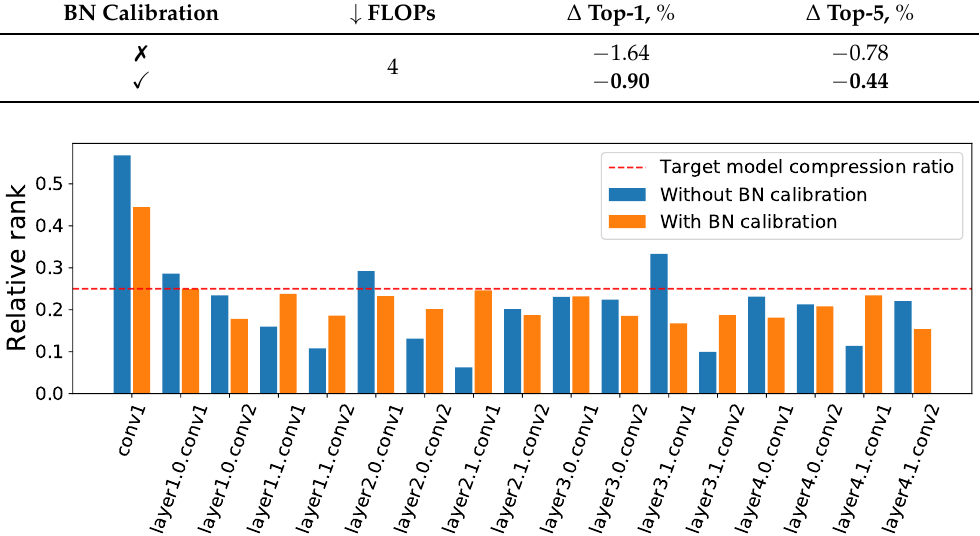
Figure 9. Visualization of related ranks found by the PARS algorithm for the search with and without the calibration of the BN